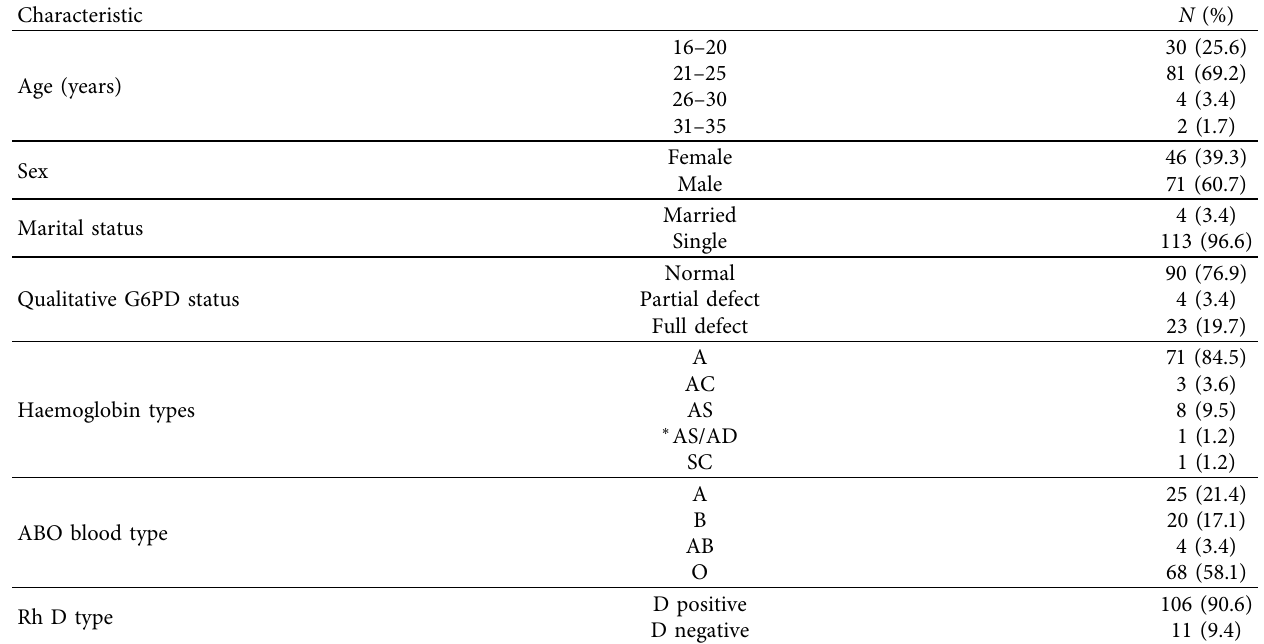
Table 1: The demographic characteristics of the participants.